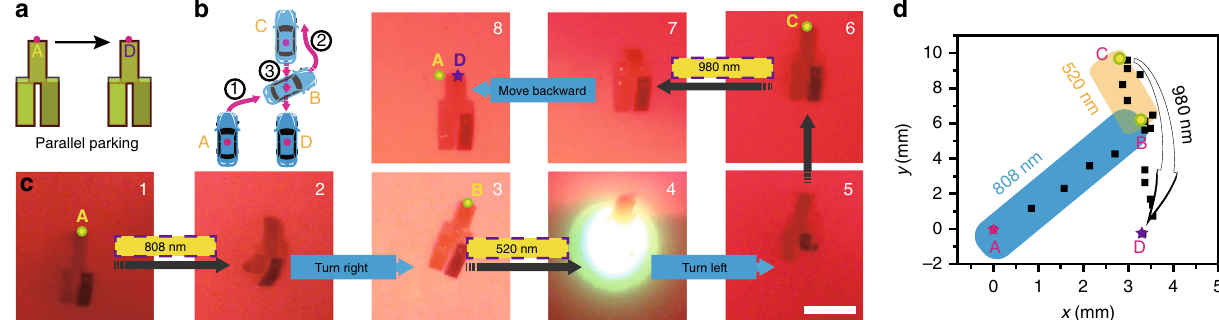
Fig. 6 Photo-guided parallel parking of LCE walker robot. Schematic illustration of a the parallel parking of a vehicle and b how a vehicle accomplishes such a horizontal movement. c Photographs showing the process of such a vehicle-like walker robot moving horizontally from position A to position D under the stimulation of 808 nm, 520 nm, and 980 nm light (scale bar = 1.0 cm). d The real-time position coordinate of the midpoint A of this LCE walker recorded in parallel parking manner. Source data are provided as a Source Data fi